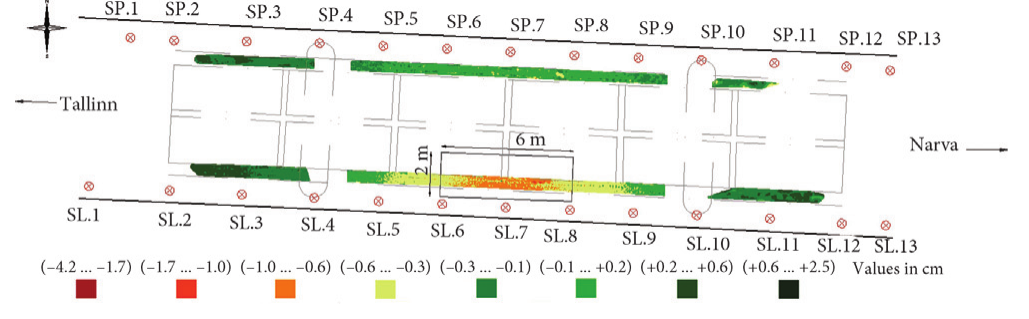
Fig. 7. Results from the loading of 785 kN force